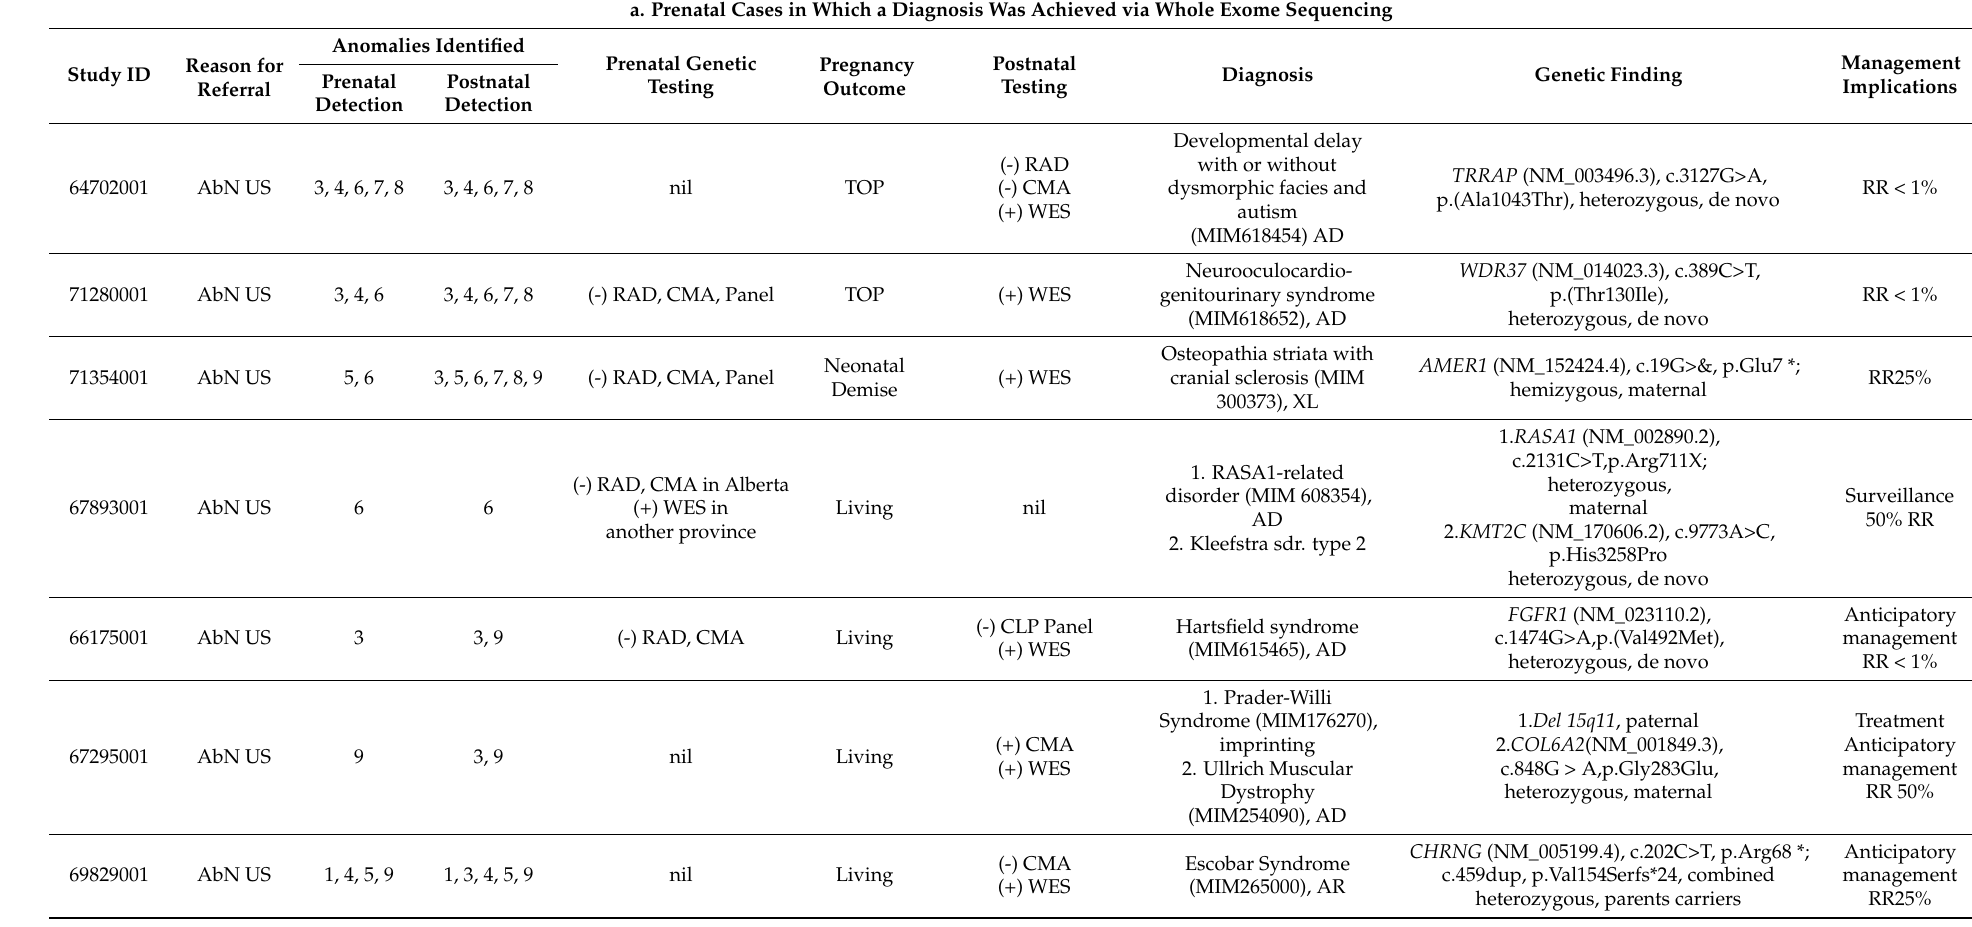
Table 2. Prenatal whole exome sequencing